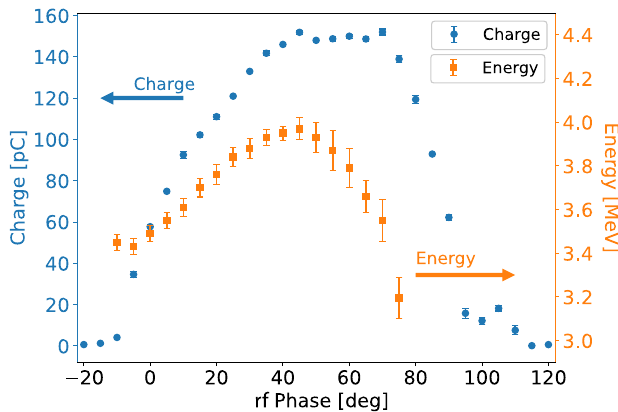
cm.FIG. 3. Schematic of the experimental setup when the TDC